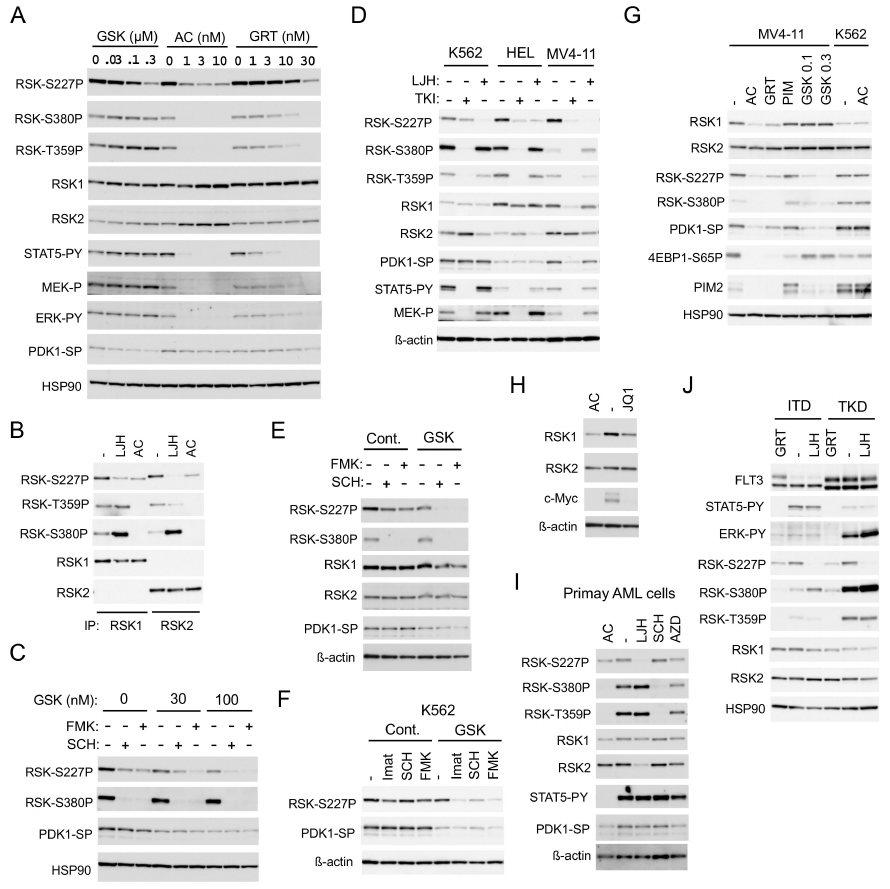
Figure 3. FLT3-ITD activates RSKs through activation of the MEK / ERK pathway and PDK1. ( A ) MV4-11 cells were treated for 6 h with indicated concentrations of GSK-2334470 (GSK), quizartinib (AC), or gilteritinib (GRT), as indicated. Cells were then lysed and subjected to immunoblot analysis with antibodies against indicated proteins. Abbreviations: RSK-S227P, phospho-S227-RSK2; RSK-S380P, phospho-S380-RSK1; RSK-T359P, phospho-T359 / S363-RSK1; STAT5-PY, phospho-Y694-STAT5; MEK-P, phospho-S217 / 221-MEK; ERK-PY, phospho-T202 / Y204-Erk; PDK1-SP, phospho-S241-PDK1. ( B ) MV4-11 cells were treated for 8 h with or without 5 µ M LJH685 (LJH) or 50 nM quizartinib, as indicated, and lysed. Cell lysates were subjected to immunoprecipitation with ant-RSK1 or anti-RSK2 antibody, as indicated, followed by immunoblot analysis. ( C ) MV4-11 cells were treated for 6 h with or without 0.1 µ M SCH772984 (SCH) or 1 µ M FMK, as indicated, with indicated concentrations of GSK-2334470 and analyzed. ( D ) K562, HEL, or MV4-11 cells were treated for 16 h with or without 3 µ M LJH685 or the relevant tyrosine kinase inhibitor (TKI: 2 µ M imatinib for K562, 2 µ M ruxolitinib for HEL, or 10 nM quizartinib for MV4-11), as indicated, and analyzed. ß-actin was used for a loading control. ( E ) MV4-11 cells were treated for 16 h with or without 0.2 µ M SCH772984, 1 µ M FMK, or 25 nM GSK-2334470, as indicated, and analyzed. ( F ) K562 cells were treated for 16 h with or without 1 µ M imatinib (Imat), 0.2 µ M SCH772984, or 1 µ M FMK in the presence or absence of 100 nM GSK-2334470, as indicated, and analyzed. ( G ) MV4-11, HEL, or K562 cells were cultured for 16 h with or without 10 nM quizartinib, 30 nM gilteritinib, 2 µ M PIM-447 (PIM), or indicated concentrations ( µ M) of GSK-2334470, as indicated, and analyzed. 4EBP1-S65P: Phospho-S65-4EBP1. ( H ) MV4-11 cells were treated for 24 h with or without 20 nM quizartinib or 1 µ M JQ1, as indicated, and analyzed. (I ) Primary FLT3-ITD-positive AML cells were treated for 24 h with or without 30 nM quizartinib, 5 µ M LJH685, 0.5 mM SCH772984, or 1 µ M AZD1208 (AZD), as indicated, and analyzed. ( J ) 32D / FLT3-ITD or -TKD cells inducibly expressing FLT3-ITD (ITD) or FLT3-TKD (TKD) and cultured without IL-3 were treated for 6 h with or without 3 µ M LJH685 or 30 nM gilteritinib, as indicated, and